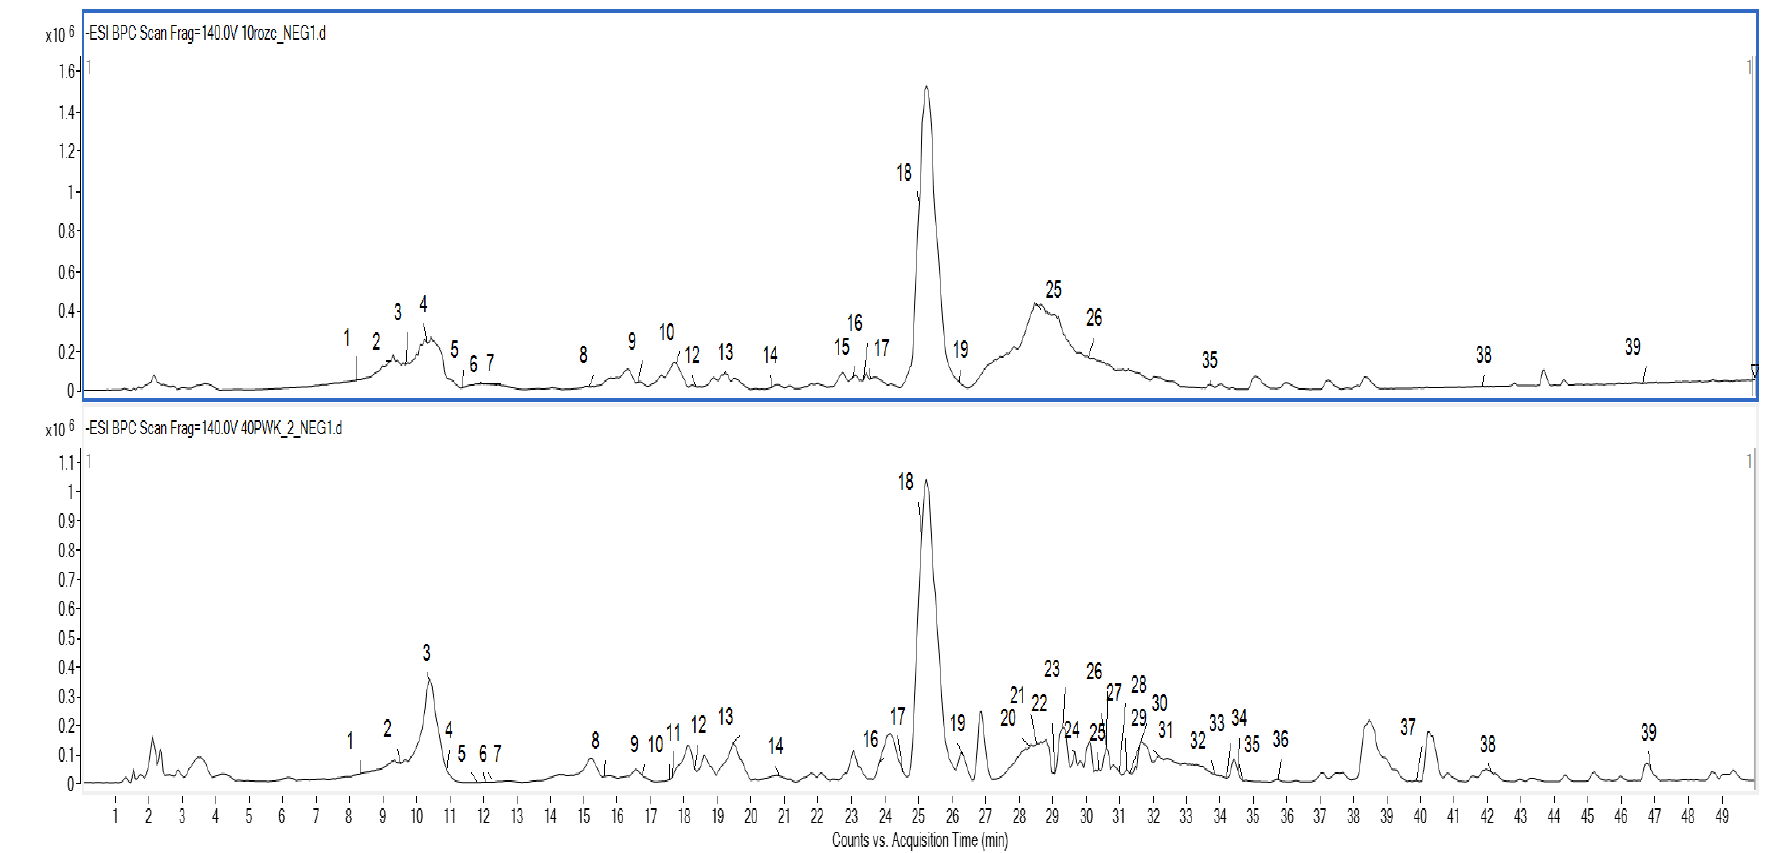
Figure 2. The base peak chromatograms of P. vulgaris aboveground parts (higher) and roots (lower) extracts. Numbers correspond to compounds described in